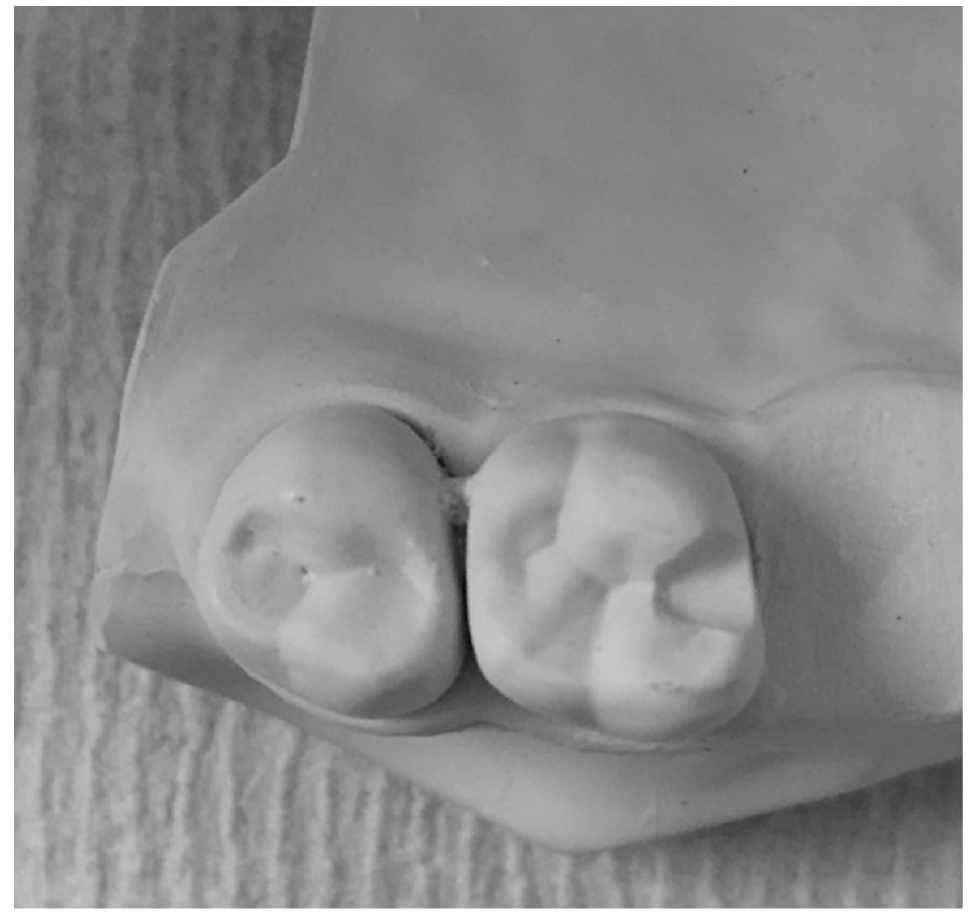
Figure 1. Representative image of maxillary second molar model prepared with mesial occlusal rest seat.